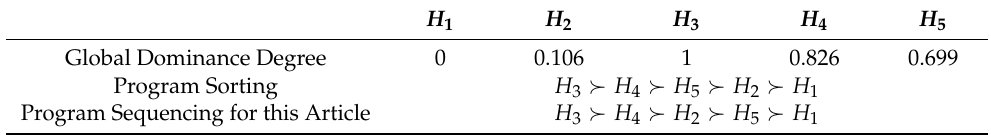
Table 6. Global dominance degree and comparison with the method in the literature [30].